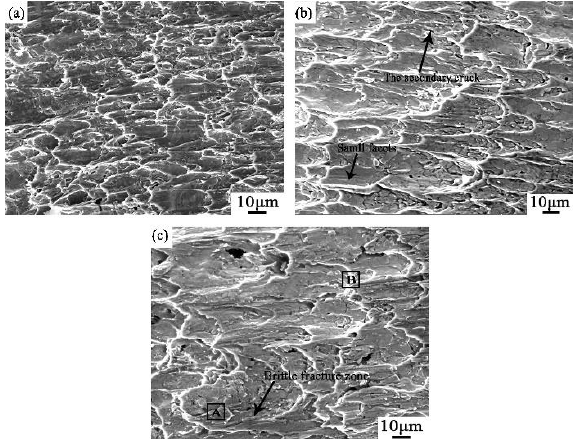
and roughness ( b ). ( a ) Thermal-cycle e ff ect; ( b ) IMC d and IMC R e ff ect.